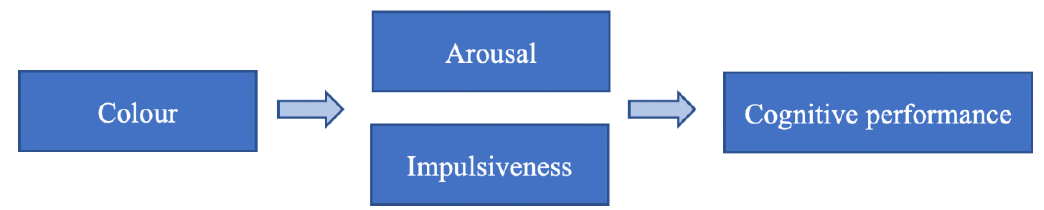
Figure 1. The relationship between the impacts of colour on people’s arousal and impulsive level and cognitive performance.